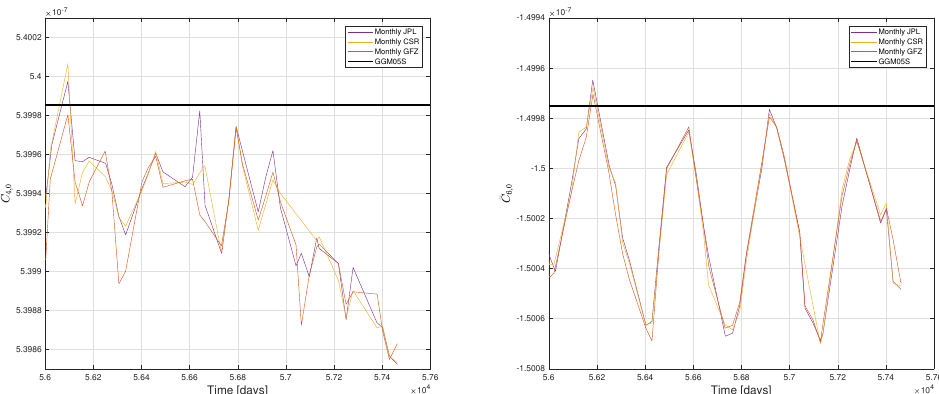
Figure 14. Time evolution of the zonal coefficients ¯ C 40 ( left ) and ¯ C 60 ( right ), as estimated on a monthly basis by CSR, JPL and GFZ, compared with their static values provided in GGM05S (horizontal, black line). For the coefficient ¯ C 60 , the GGM05S static value not only fails to describe the secular trend (and the oscillations), but it predicts a value not even close to the mean value over the analysis period. The same is true also for the ¯ C 40 coefficient, but with an overall smaller impact in the performed POD.